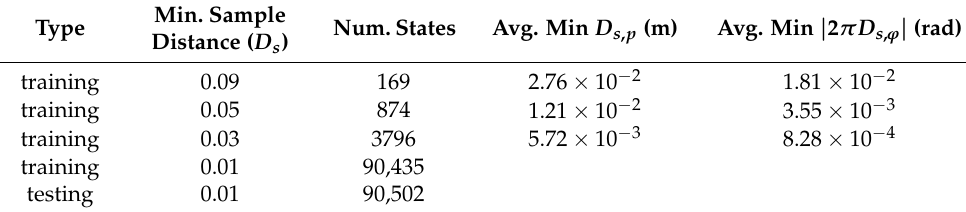
Table 1. An overview of the data sets used in this study. The minimum distance between samples D s controls the number of source states. A source state is specified by a position p and orientation ϕ . The distance between two states was computed as the Euclidean distance in the combined x – y – ϕ /2 π space containing all possible combinations of source positions and movement directions. The orientation dimension was divided by 2 π to balance the number of positions and orientations. The testing data set has a different number of source states than the training set with D s = 0.01, due to the randomness of Poisson Disc sampling [37]. The average distance to the closest neighbour within each data set is indicated for both the position and orientation to support the interpretation of D s